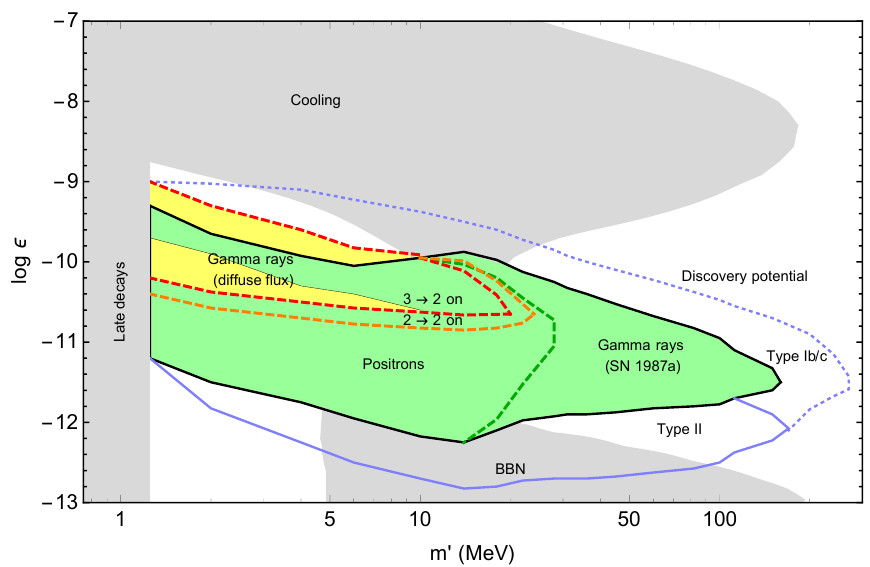
Figure 1 . The overall region excluded by this work is colored in green. The blue curves show the region in which we could discover the dark photon during the next galactic SN. The solid blue curve is drawn considering the case of a Type II SN, the dotted blue curve a Type Ib/c. Yellow regions indicate where a simple analysis of the di(cid:11)use (cid:13)ux fails to place a constraint, though a more involved analysis would likely constrain these regions as well. The positron bound rules out parameter space between the red and the green dashed lines. The gamma-ray constraint from SN1987a extends the excluded region to higher masses (past the green dashed line), and the di(cid:11)use gamma-ray (cid:13)ux to stronger couplings (above the red dashed line). The orange dashed line indicates where a plasma forms but only 2-to-2 processes are on, whereas the red dashed line indicates where a (cid:12)reball with 2-to-3 processes occurring forms. Previous bounds are shown in gray. The cooling bound is reproduced from [5] and the BBN constraint from [32]. The late decay bound is taken from [33] and comes from considering the decay of dark photons on cosmological timescales (see also